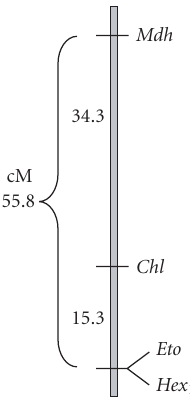
Figure 1: Gene map of a linkage group of loci for malate dehydrogenase ( Mdh ), resistance to chlorfenapyr ( Chl ), etoxazole ( Eto ), and hexythiazox ( Hex 1 ) in T. urticae .